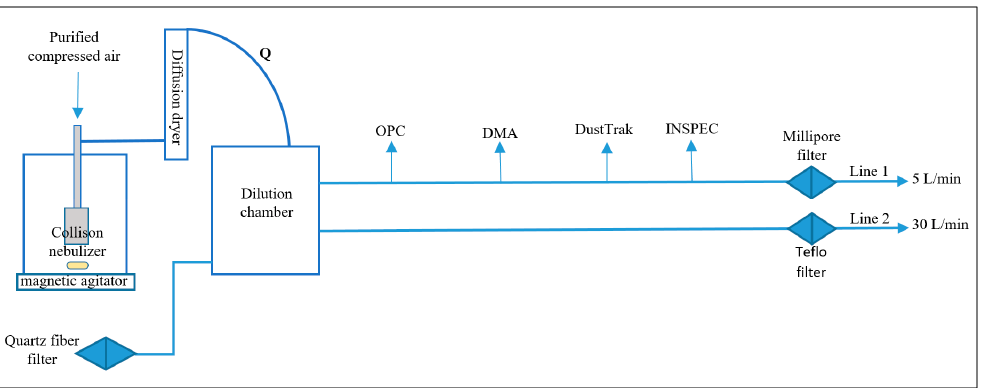
Figure 1. Diagram of experimental setup. A magnetic agitator was used to maintain uniform suspension composition, given the high bulk material densities.